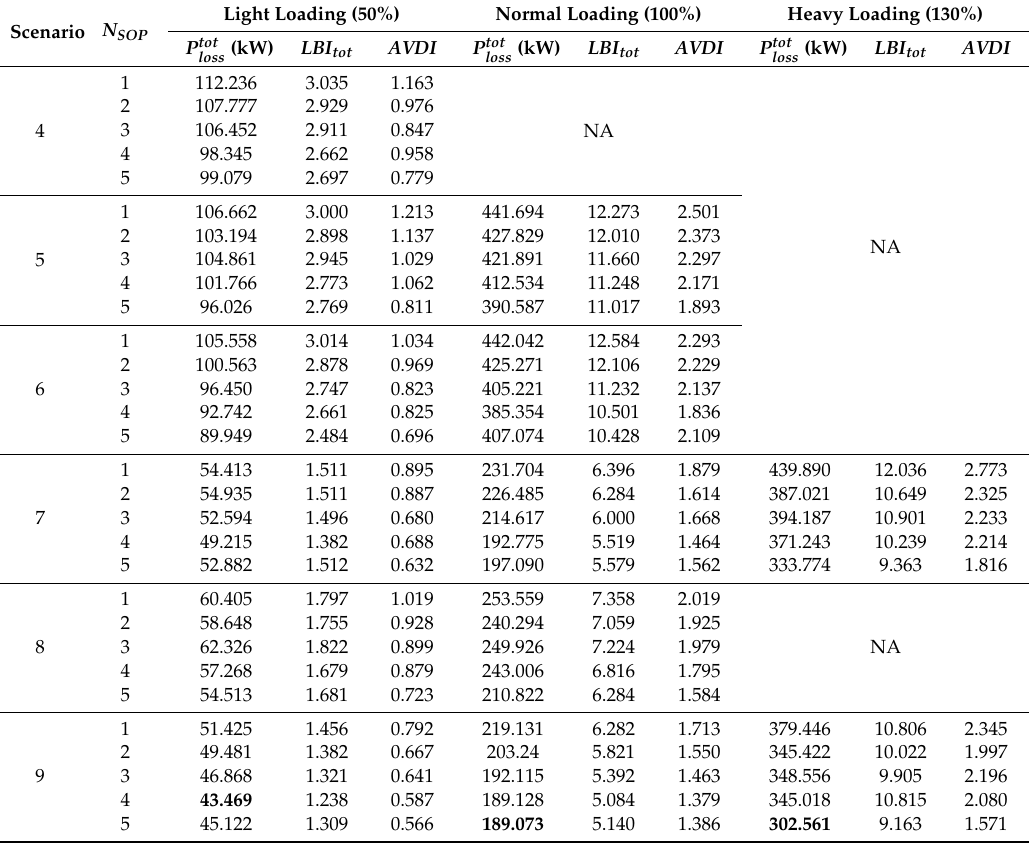
Table 6. Total power losses and PQ indices for scenarios 4 to 9 without SOP losses: 83-node system. Scenario N